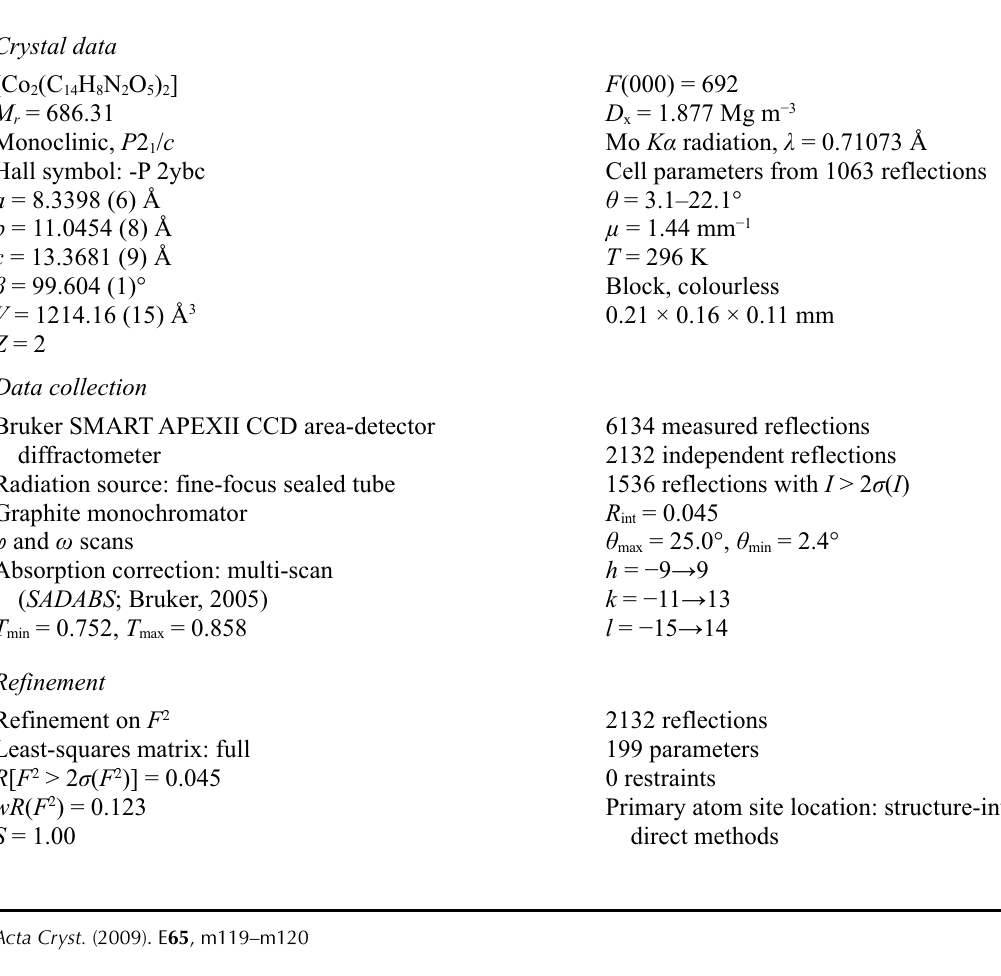
Figure 4 Emission spectra of the ligand and complex (I) in ethanol solution, λ bis{ µ